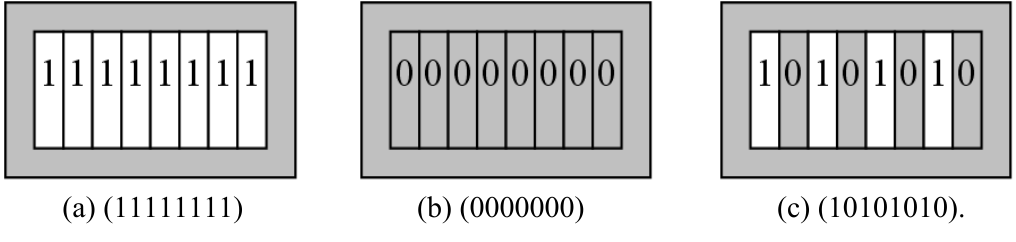
Figure 6. Circular-hole coding (a) (10101010); (b) (11111000); (c) (11001100).